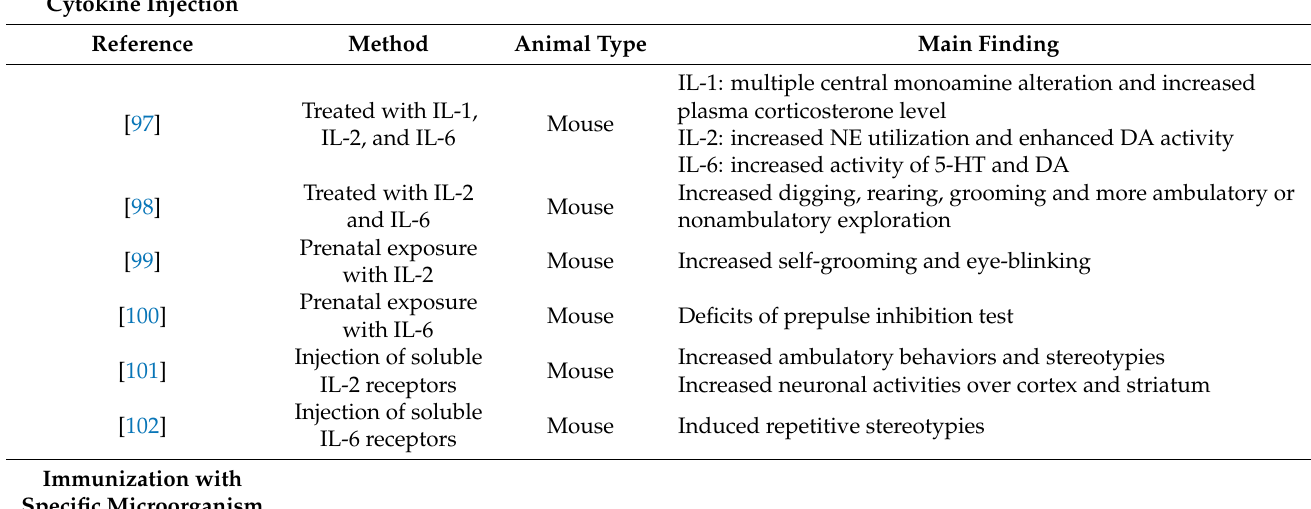
Table 2. Findings of immunological involvement in animal